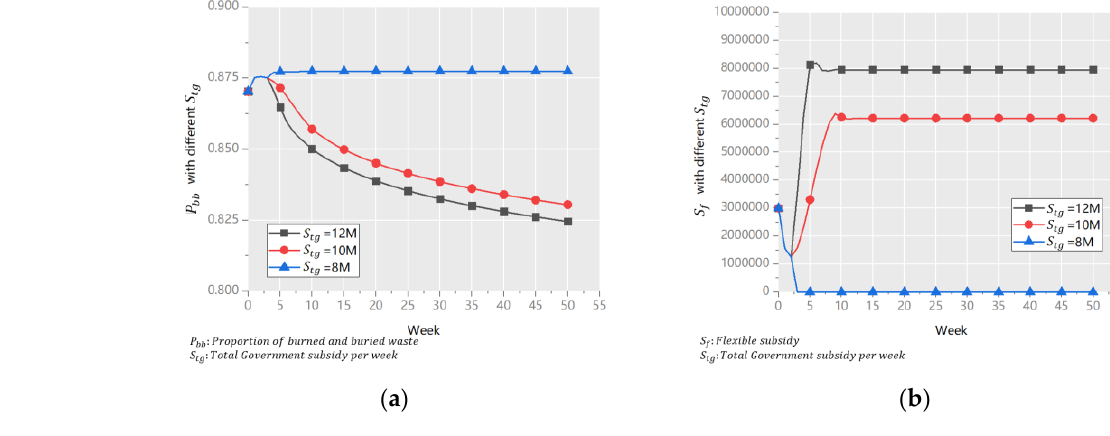
Figure 7. P bb ( a ) and S f ( b ) with different S